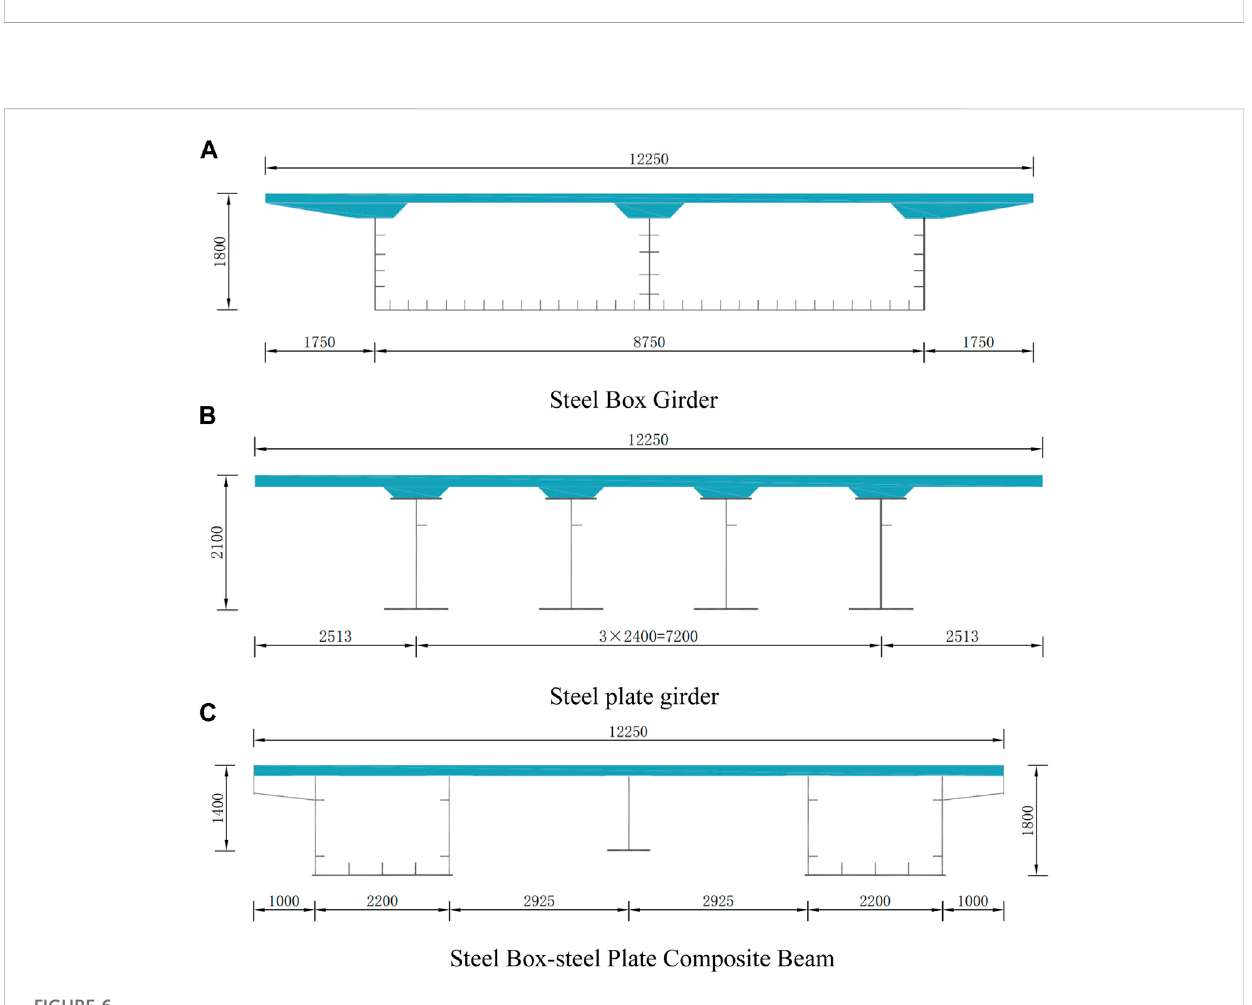
Calculation section of composite